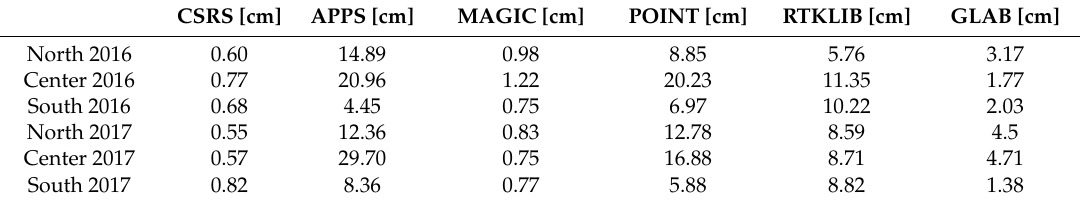
Table 5. RMSE values in centimeters by groups in July 27th 2016 and 2017.